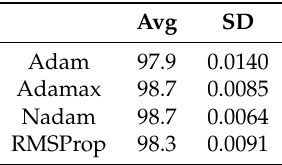
Table 2. Optimizer Averages and Standard Deviations.